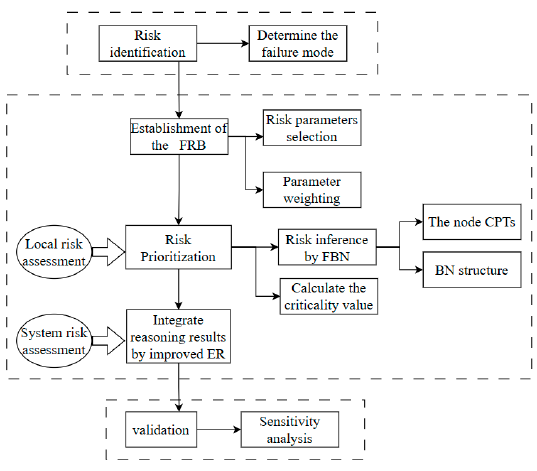
Figure 1. Maritime logistics risk assessment model.